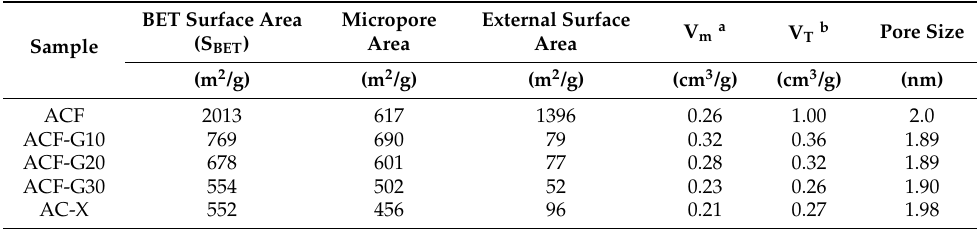
Table 1. Textural properties of the carbon catalysts.